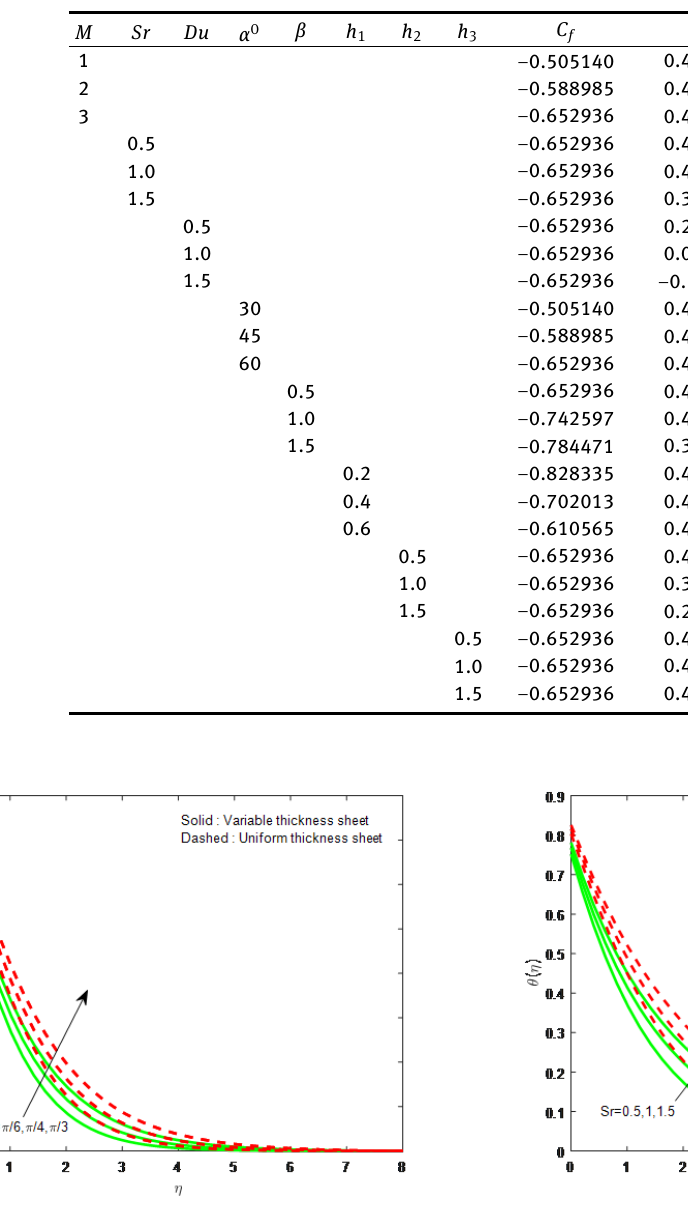
Fig. 7: Influence of α on concentration field